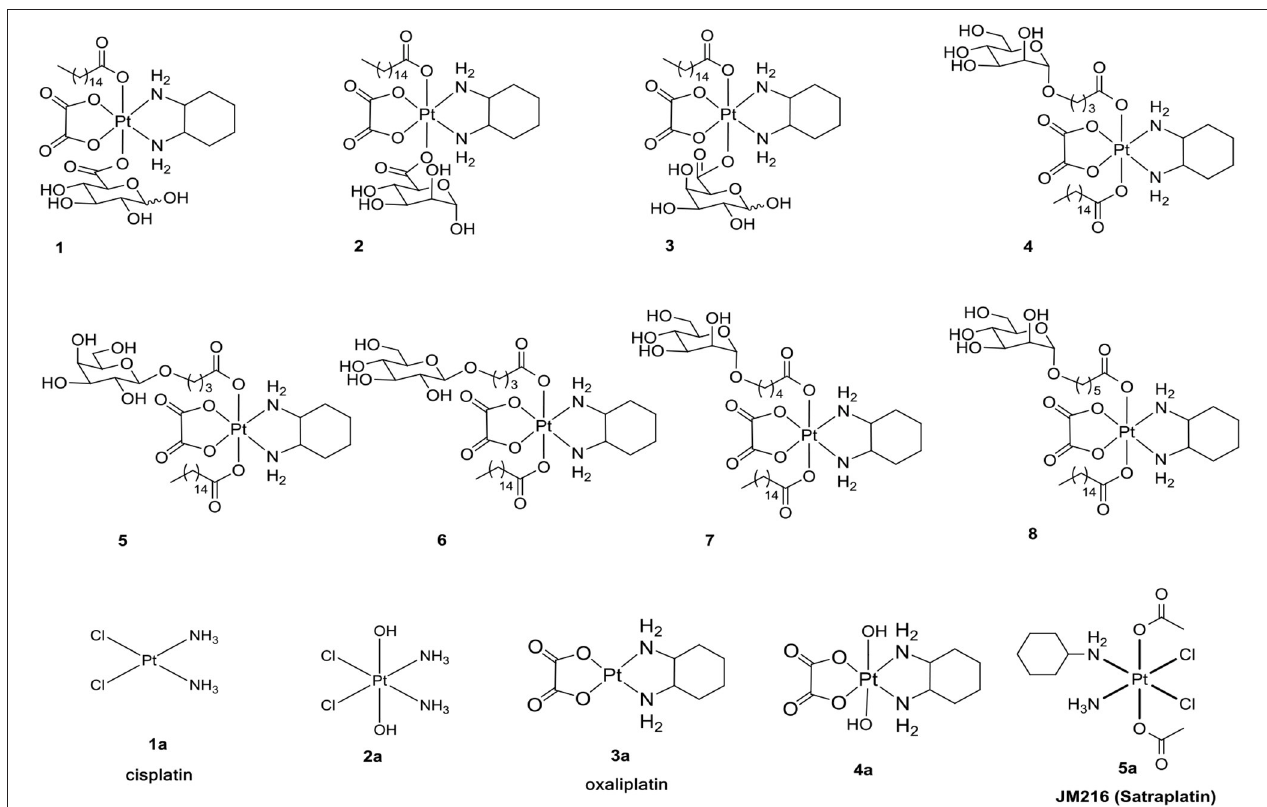
FIGURE 1 | Structures of 1 - 8 and 1a - 5a as positive controls.